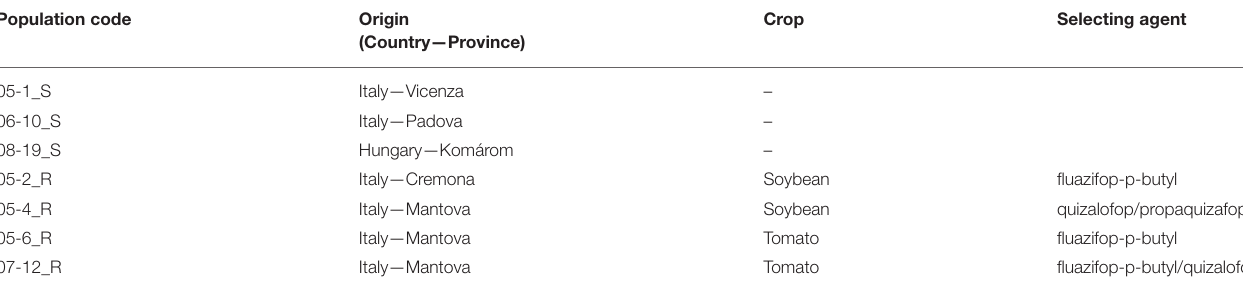
TABLE 1 | Details of populations investigated in the growth analysis experiments. Population